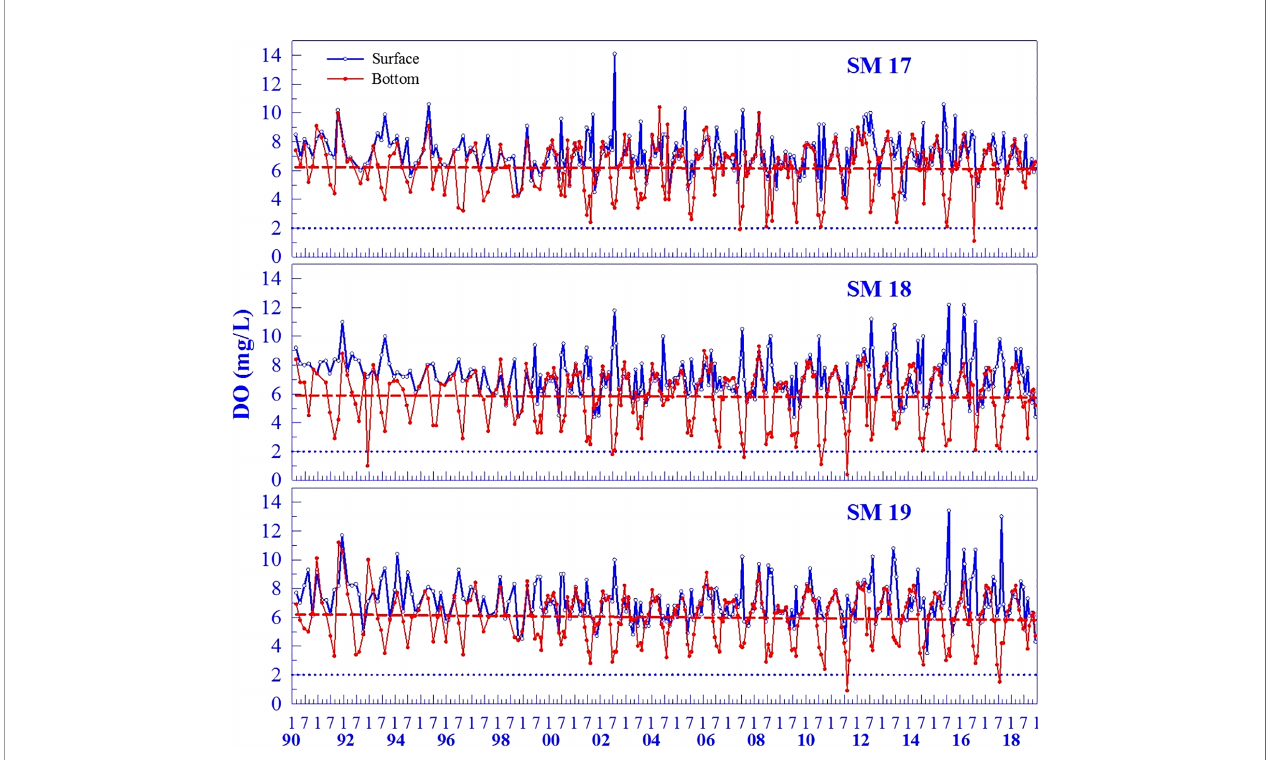
FIGURE 3 | The time series of surface and bottom DO during 1990-2018 at SM17, SM18 and SM19 (the red dashed line indicates that the linear regression is not signi fi